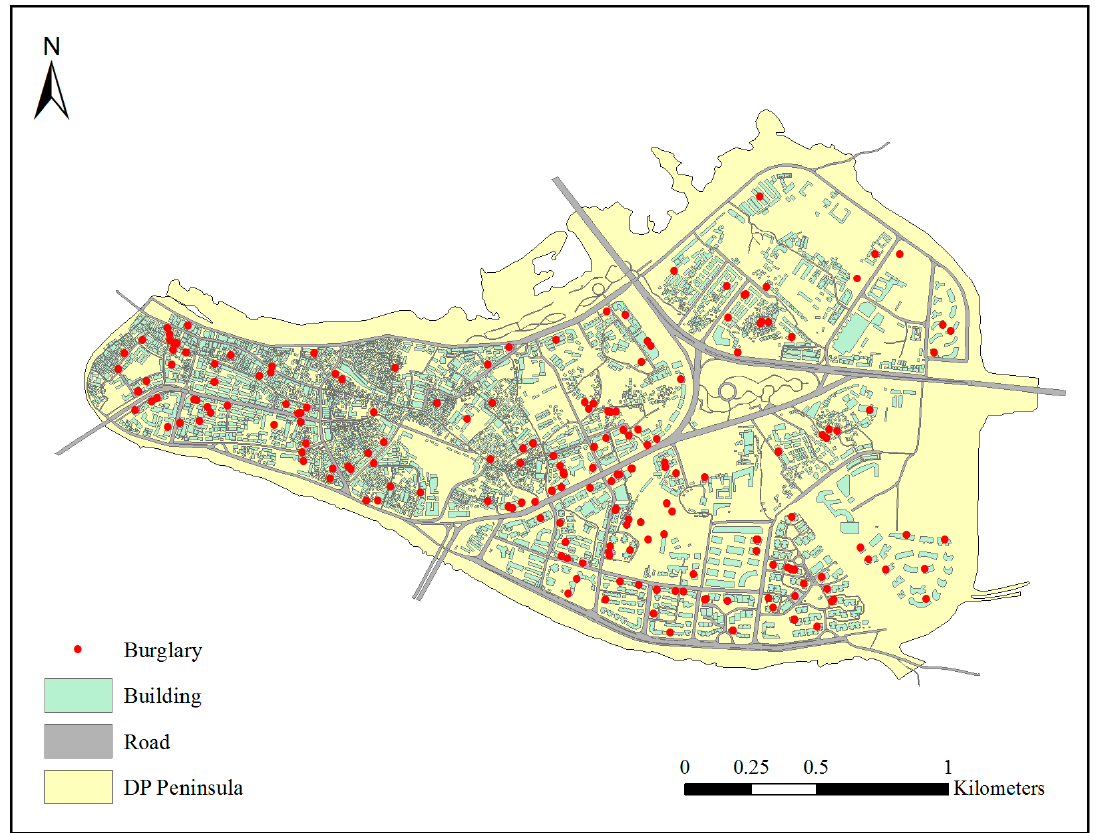
Figure 3. The spatial distribution of burglary events in the study area in